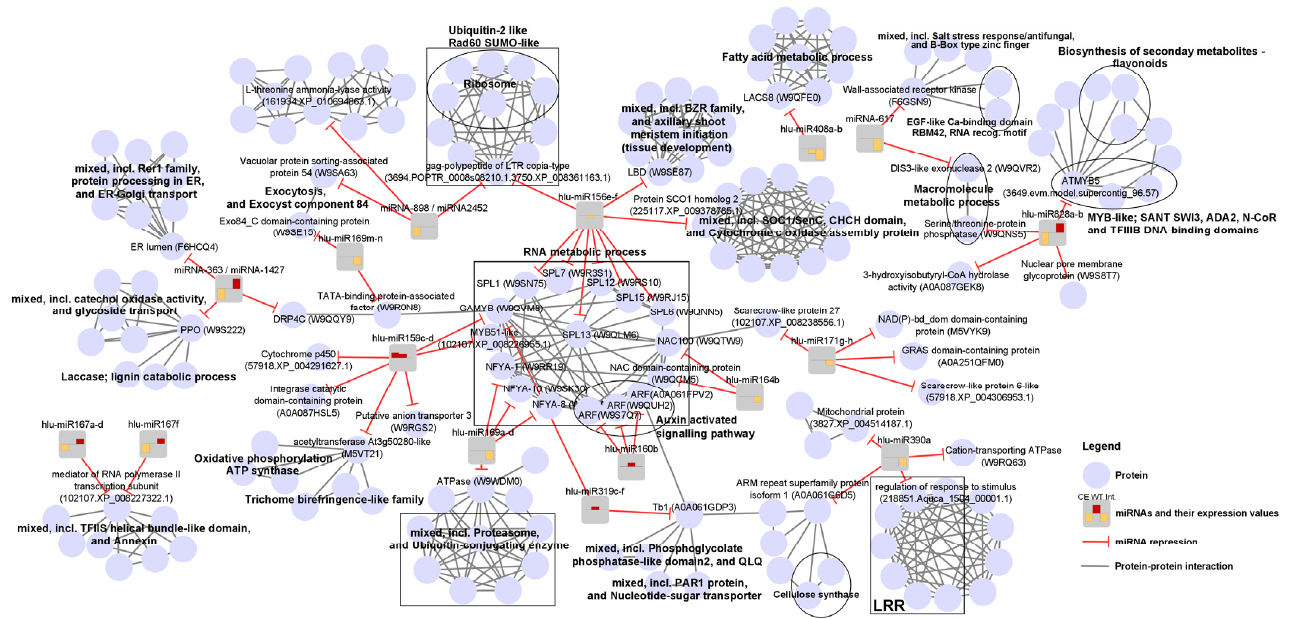
Figure 4. Protein–protein interaction network of miRNAs and their targets with interactors. Blue circles represent proteins and interactions between them (grey lines), and grey round rectangles with bar plot represent miRNAs repressing their targets (red lines with T-shaped arrowhead indicating target repression). The first and second bars of the miRNA bar plot represent miRNA expression levels (red, upregulated; orange, downregulated) determined by DESeq2 analysis for the sensitive hop cultivar Celeia (CE) and the resistant hop cultivar Wye Target (WT), respectively, upon inoculation with V. nonalfalfae . The third bar represents the interaction (Int.), defined as the difference between the condition effect for the resistant cultivar compared to the condition effect for the susceptible cultivar. Enriched terms of local network clusters obtained by the STRING Enrichment analysis are shown in bold. miRNA target names have either UniProt (Entry) or STRING identifier. ARF, Auxin response factor; NF-YA, Nuclear transcription factor Y subunit A; SPL, Squamosa promoter-binding-like protein; DRP4C, Dynamin-related protein 4C; LBD-LOB domain-containing protein; LRR, Leucine-rich repeat proteins; Tb1, Teosinte branched 1; LACS8, Long chain acyl-CoA synthetase 8; ER, endoplasmic reticulum.